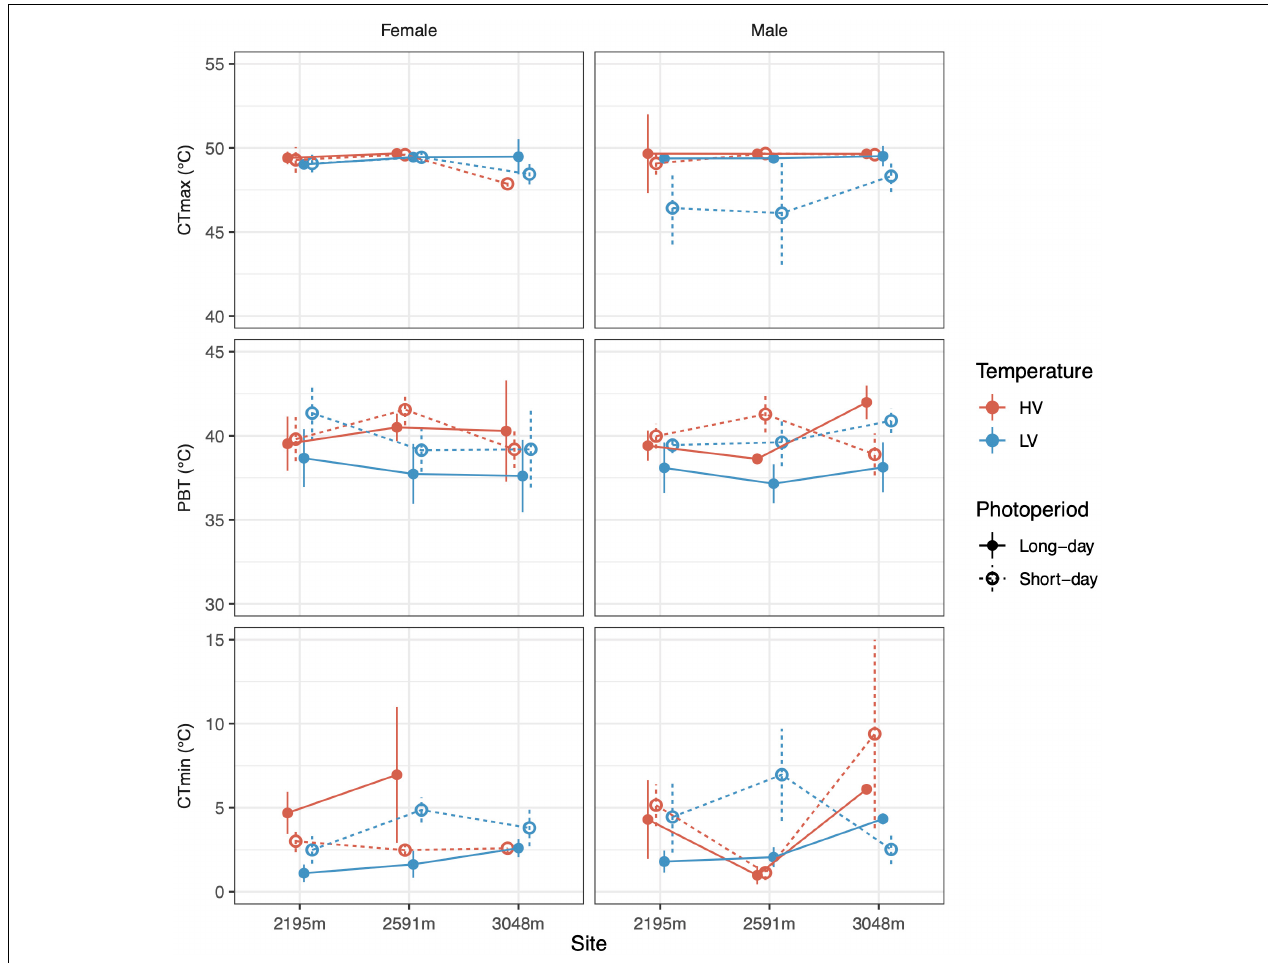
FIGURE 3 | Photoperiod (line type) and temperature variance (colors) alter CT min (bottom row) but not CT max (top row) of male and female (columns) grasshoppers from different populations ( X -axis). Mean preferred body temperatures (middle row) of lab-reared grasshoppers do not differ significantly based on sex, photoperiod, temperature variance, or population. Error bars represent standard error.